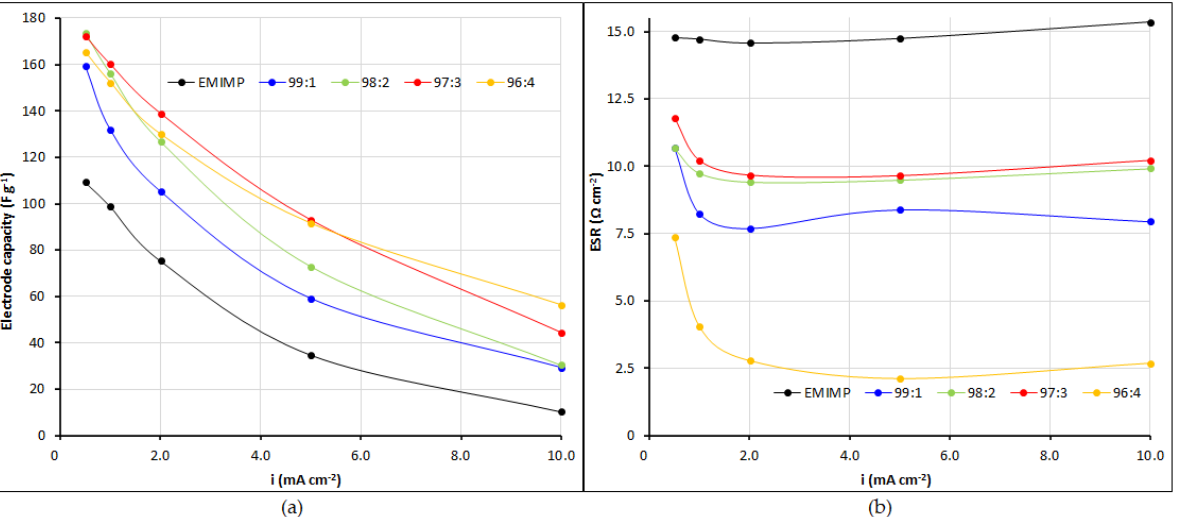
Figure 6. ( a ) Electrode capacity and ( b ) internal resistance (ESR) of the supercapacitors with EMIMP and EMIMP/CNFc mixtures (99:1, 98:2, 97:3 and 96:4) as electrolyte at different charge-discharge current rates.